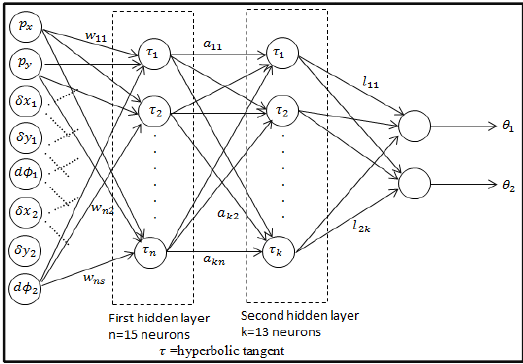
Fig. 14. the structure of kinematic inverse neural